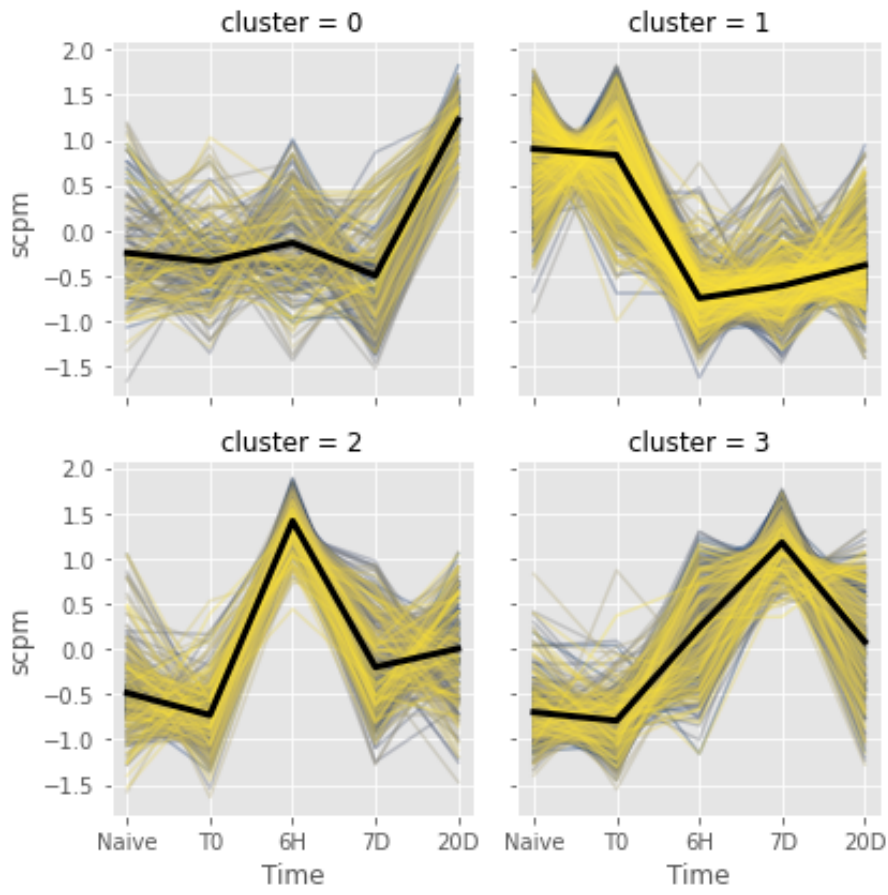
Figure 5. Spaghetti plots of gene expression patterns identified by K-means clustering of DEGs from the stabling stress test in brain. The x -axis reports the experimental time point and the y -axis reports expression levels as scaled log (CPM). The thick black line represents average, and the gray area represents the bootstrap confidence